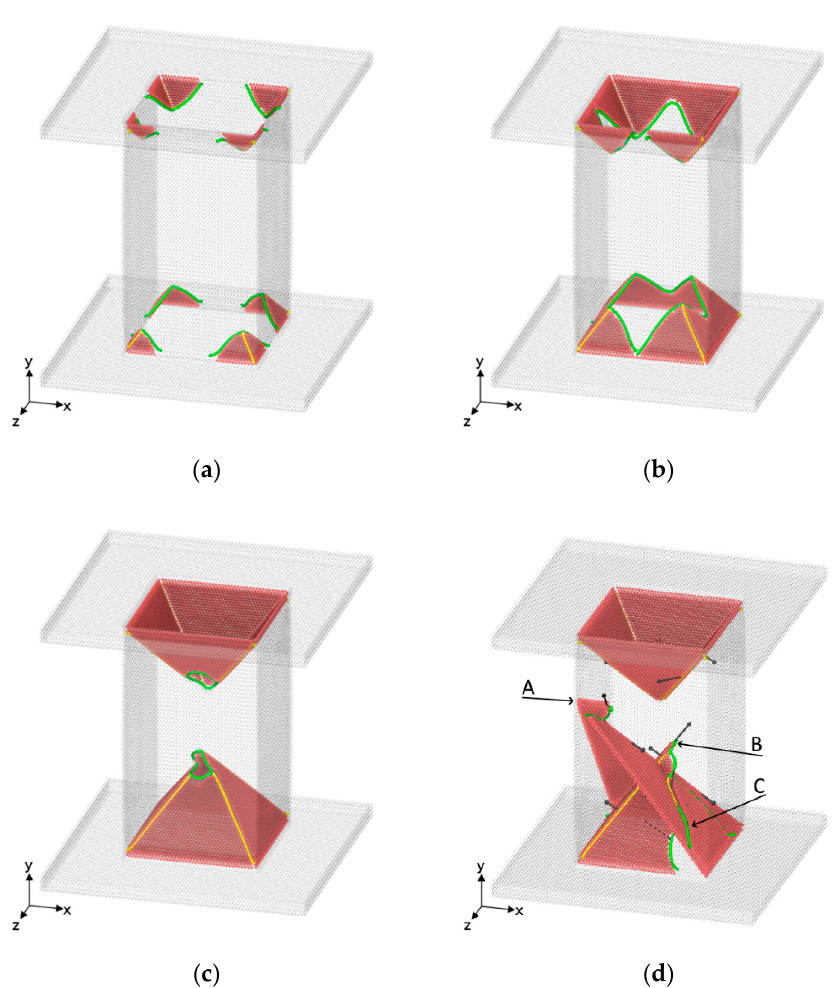
Figure 3. Deformation patterns in a < 001 > single crystal with h / d = 2 and {110} lateral faces at a sequentially increasing strain of ( a ) 7.39%; ( b ) 7.42%; ( c ) 7.44%; and ( d ) 7.51% (1 / 6 < 112 > Shockley partial dislocations colored green, 1 / 3 < 001 > Hirth dislocations colored